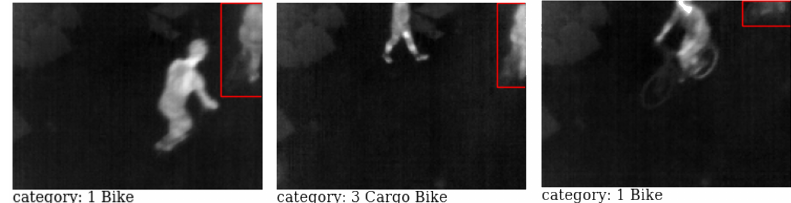
Figure 12. Examples for adverse labeling, the red box marks the ROI of the labeld